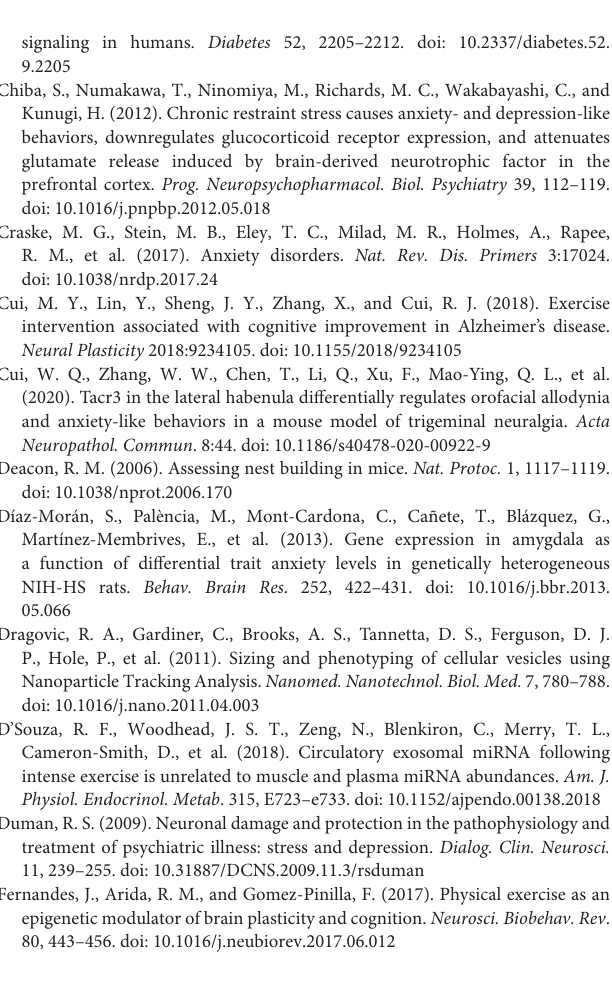
Supplementary Figure 1 | The validation of 4 weeks of voluntary wheel exercise mice sera-isolated EVs miRNAs through RT-qPCR. (A–D) miR-10b-5p, miR-let-7i-5p, miR-342-3p, and miR-29b-3p miRNA levels normalized by miR-16. ∗∗∗ p < 0.001, ∗∗∗∗ p < 0.0001 vs. S. Statistical analysis was performed with the aid of the one-tailed Student t -test. S, sedentary group ( n = 6); E, exercise group ( n = 6). The data represent means ± SEM ( ∗ p < 0.05). Supplementary Figure 2 | Cumulative distribution plots of miR-29-3p target and non-target genes. (A) Fold change means restraint / non-restraint group. (B) Fold change means restraint exercise / restraint sedentary